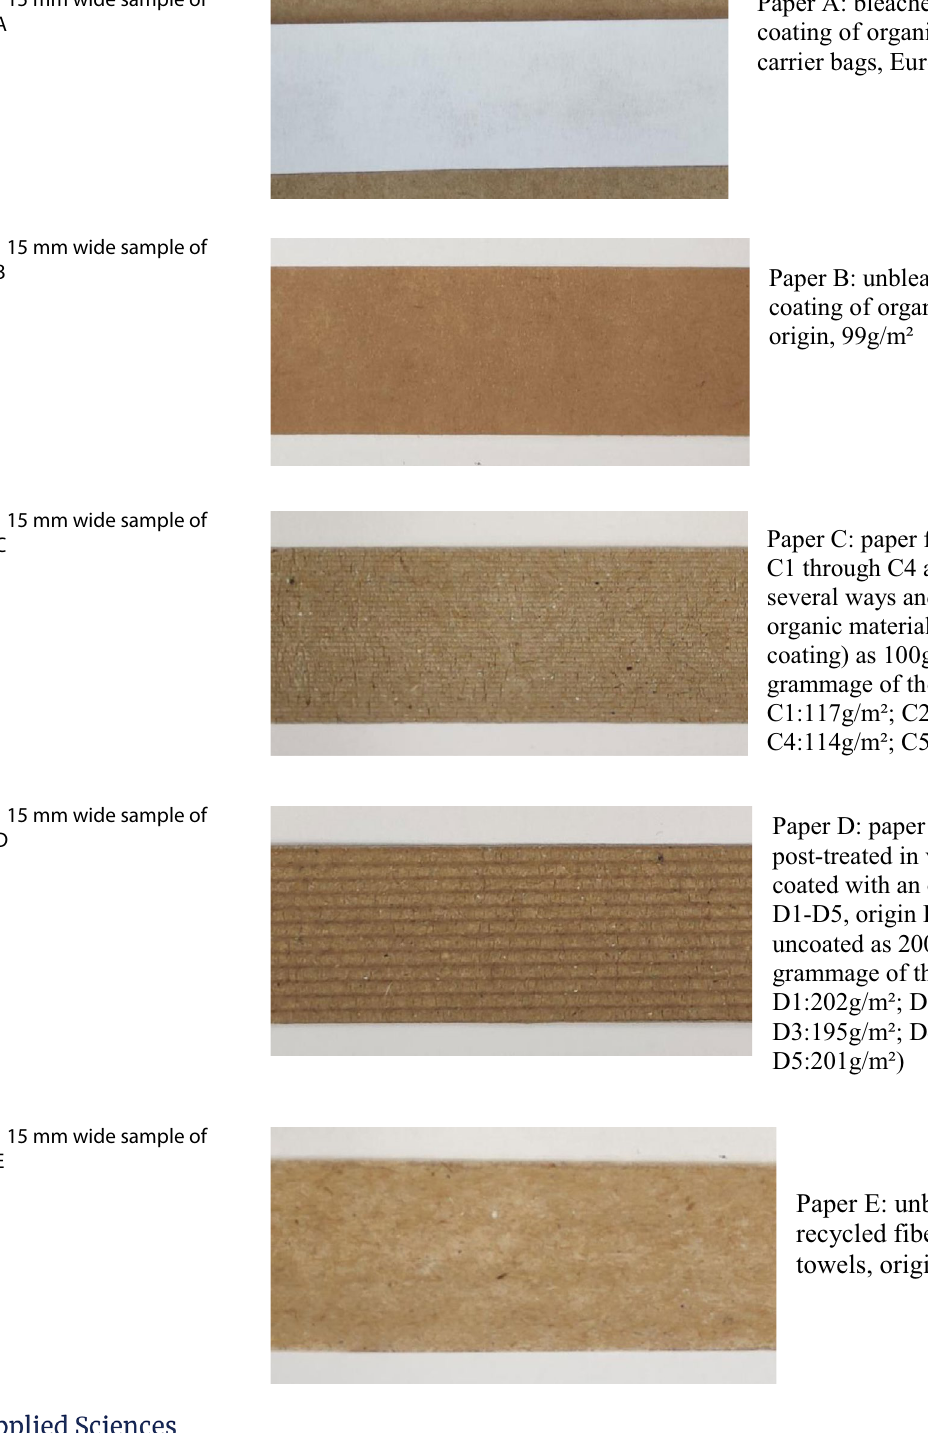
Fig. 15 15 mm wide sample of paper B